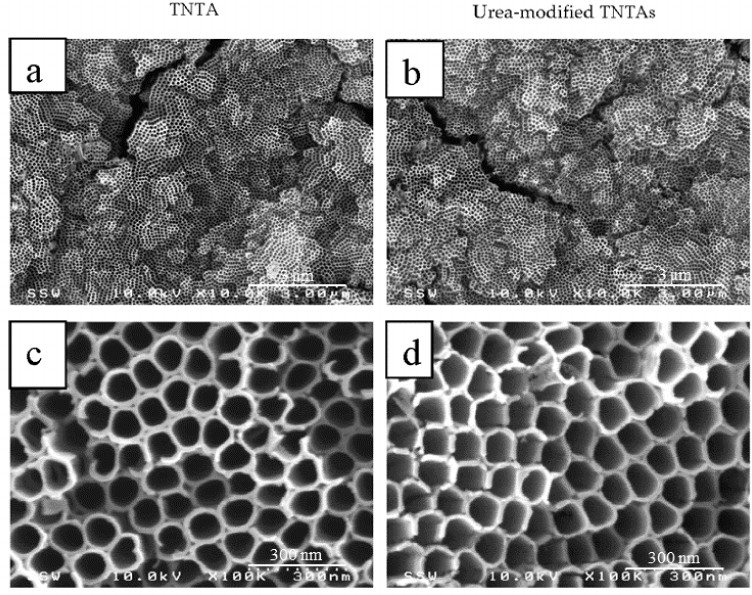
Figure 2. FESEM images of pristine (unmodified) and modified TNTAs: ( a , c ) top view and high magnified top view of pristine TNTAs; ( b , d ) top view and high magnified top view of modified